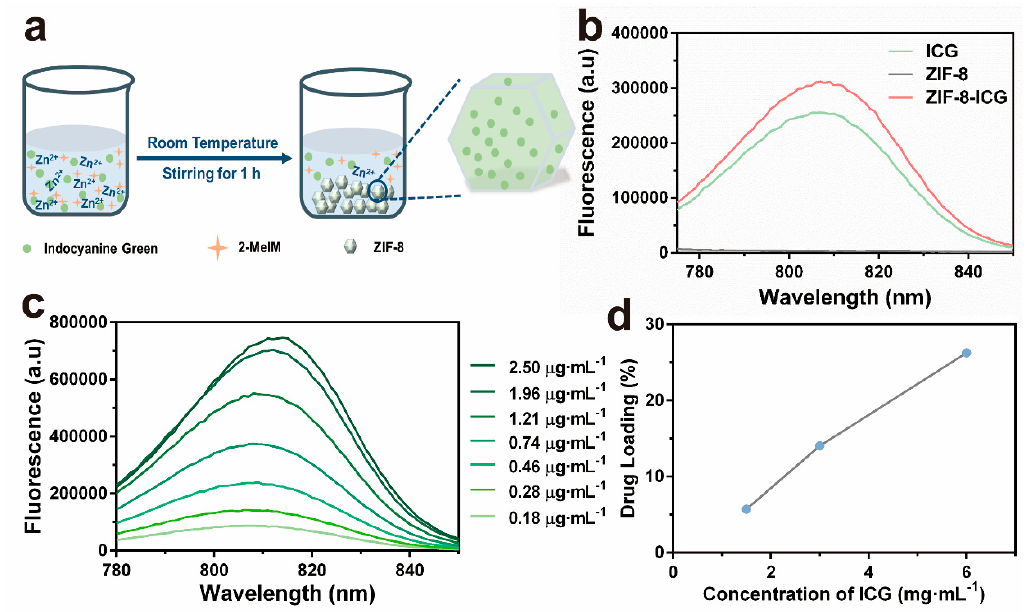
Figure 1. ( a ) Schematic representations for the in situ fabrication process of indocyanine green (ICG)-loaded zeolitic imidazolate frameworks-8 (ZIF-8) nanoparticles (ZIF-8-ICG); ( b ) The fluorescent spectrum of ICG, ZIF-8, and ZIF-8-ICG; ( c ) Fluorescent spectra of ICG solution with different concentrations at the 760 nm excitation wavelength; ( d ) The ICG-loading capacity of ZIF-8 by optimizing the reactant concentration of